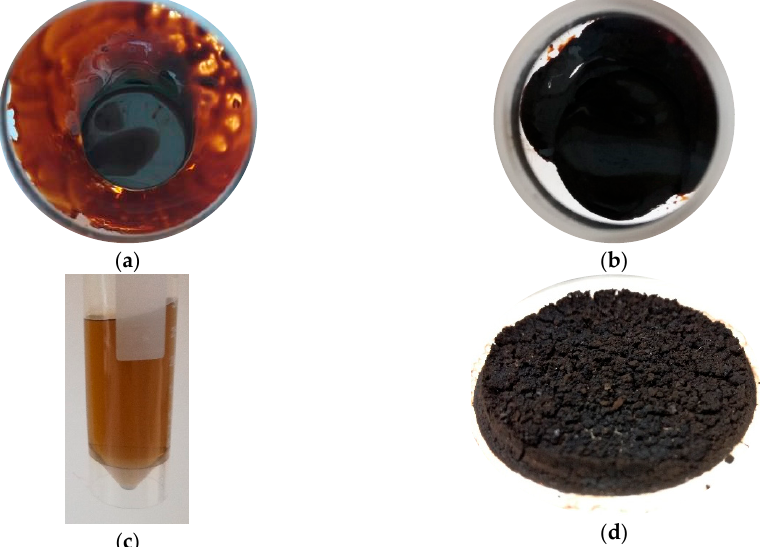
Figure 2. Products collected from a typical hydrothermal liquefaction (HTL) experiment in the micro-batch reactors: ( a ) light biocrude or BC1; ( b )heavy biocrude or BC2; ( c ) aqueous phase with water-soluble organics (WSO); ( d ) solid residue.